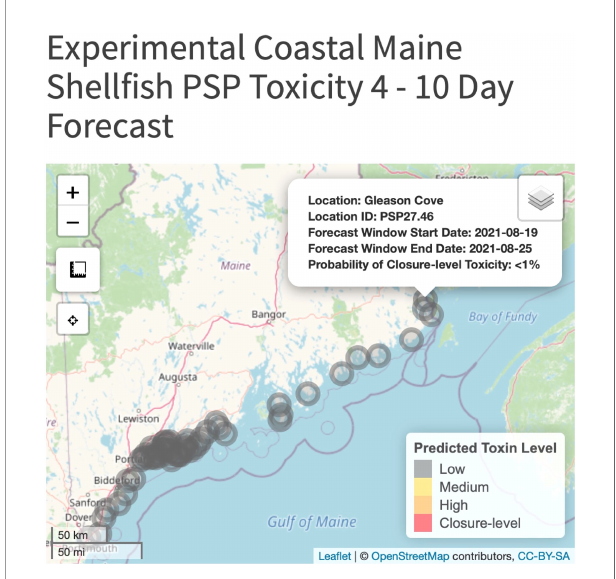
FIGURE 1 | PSP toxicity forecast communication tool, developed by the Maine DMR. The tool provides a simple site-clickable map with closure-level toxicity prediction expressed as a probability (%). Forecasts are available here: